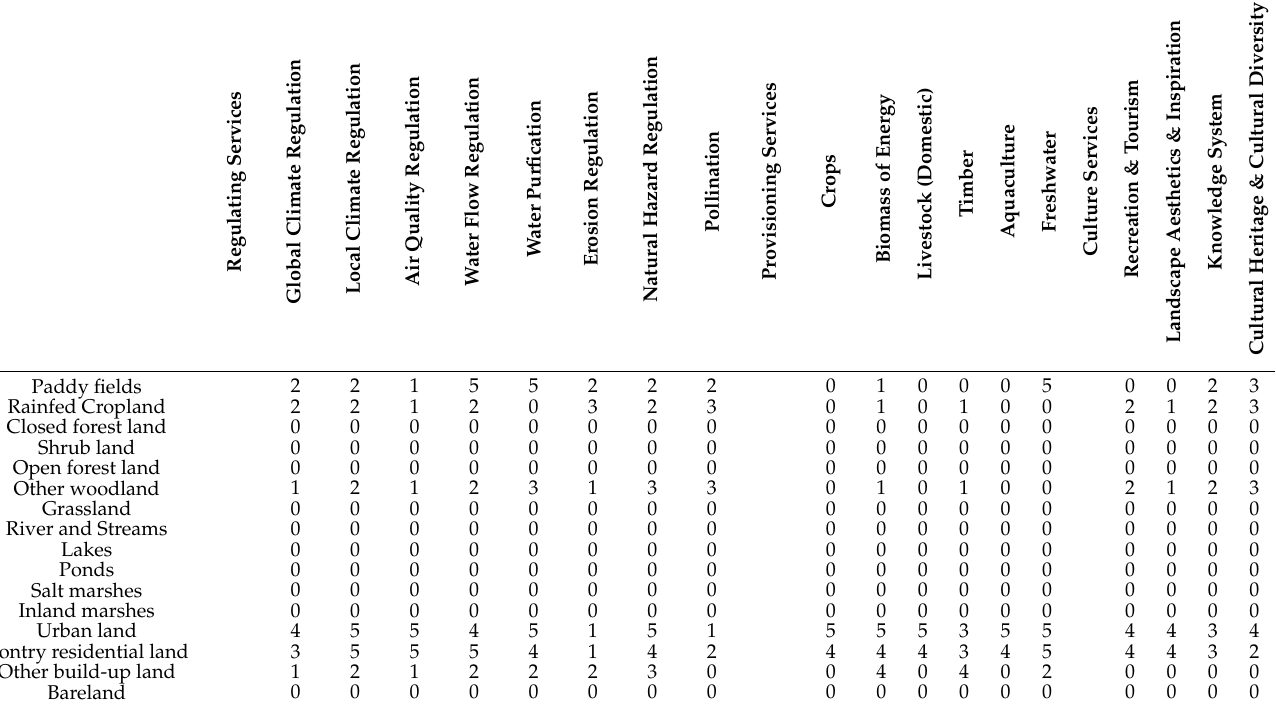
Table 5. Ecosystem services demand matrix. Scale from 0- = no relevant demand; 1 = low relevant demand; 2 = relevant demand; 3- = medium relevant demand; 4- = high relevant demand; and 5- = very high (maximum) relevant demand (After Burkhard et al.,